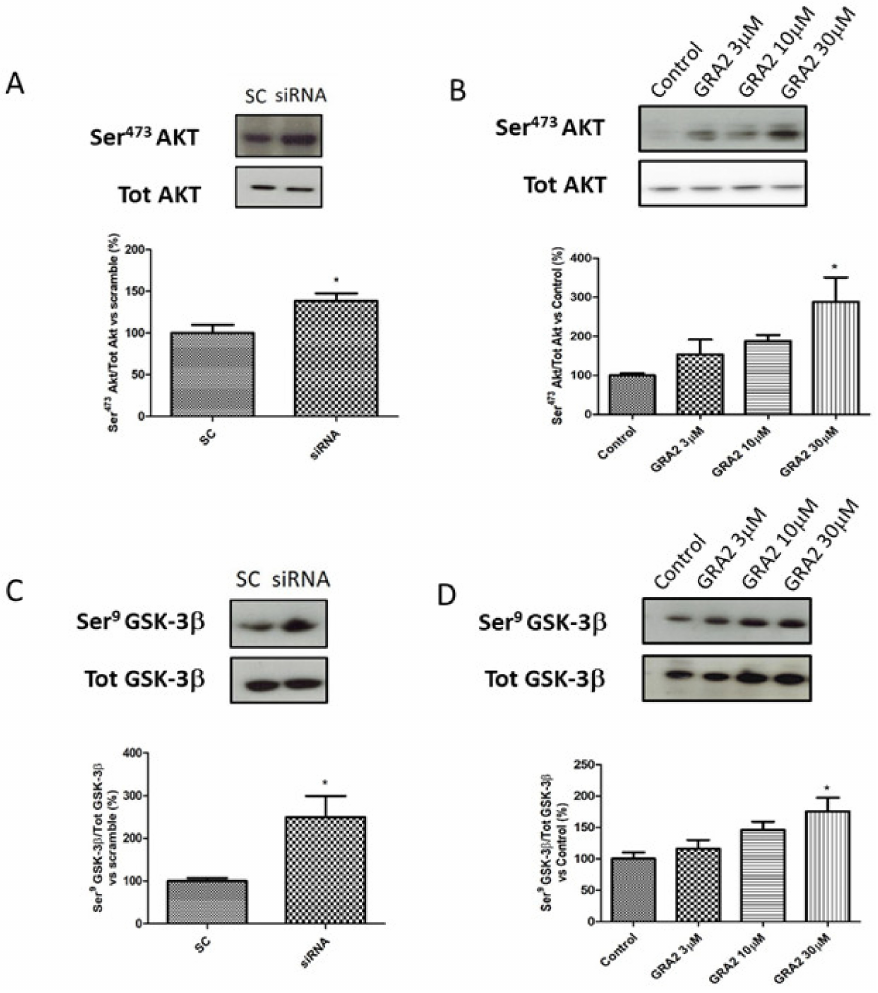
Figure 6. Effect of GPR21 inhibition on insulin signalling in HepG2 cells. Western blot analysis of phosphorylation levels of Ser 473 Akt and Ser 9 GSK-3 β in HepG2 cells transfected for 72 h with non-silencing siRNA (scramble control, SC) or with specific siRNA against GPR21 (siRNA, panel ( A , C )) as well as in HepG2 cells exposed to increasing concentrations of inverse agonist GRA2 (3–30 µ M, 24 h, panel ( B , D )). Equal loading was evaluated by a re-probing membrane with total Akt or GSK-3 β . Densitometric analysis of the bands is expressed as relative optical density (O.D.) and was normalised using the related control band. Data are expressed as mean ± SEM; n = 4. * p < 0.05 vs. scramble control (SC) or